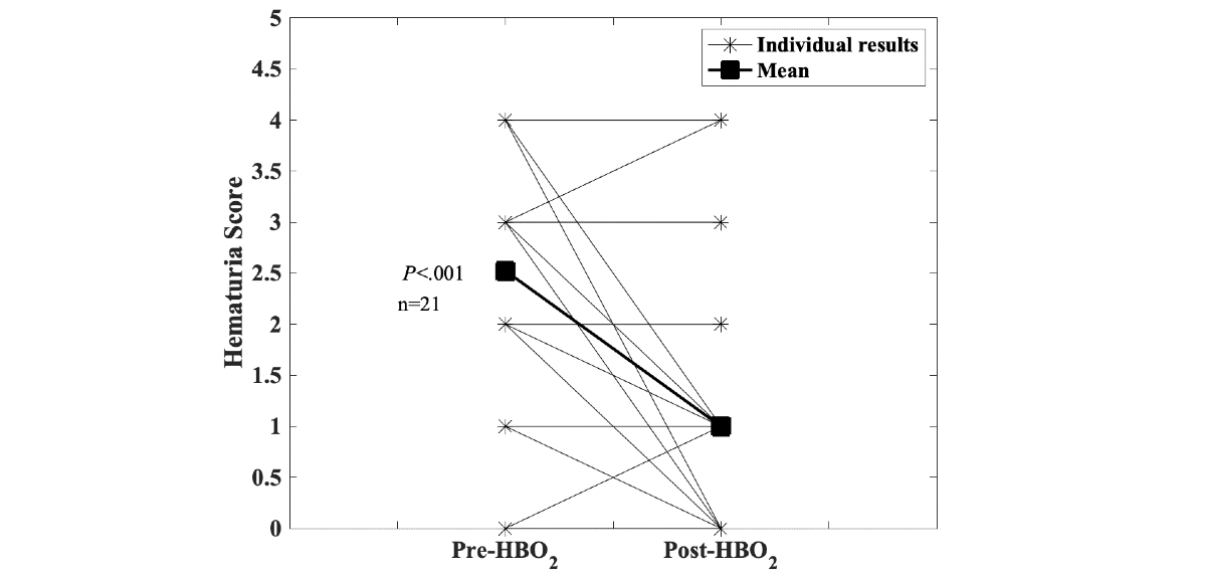
Figure 3. Delayed radiation injury, radiation cystitis. Scores on the hematuria scale before and after hyperbaric oxygen (HBO 2 ) treatment are shown: 0=no hematuria, 1=microscopic hematuria, 2=occasional macroscopic hematuria, 3=frequent macroscopic hematuria, and 4=severe hemorrhagic cystitis. Most patients see an improvement in hematuria score (2.5 pretreatment to 1.0 posttreatment, P <.001, Wilcoxon signed-rank test). As the number of entries in the registry grows, these data may be useful for assessing the number of treatments needed for successful outcomes.